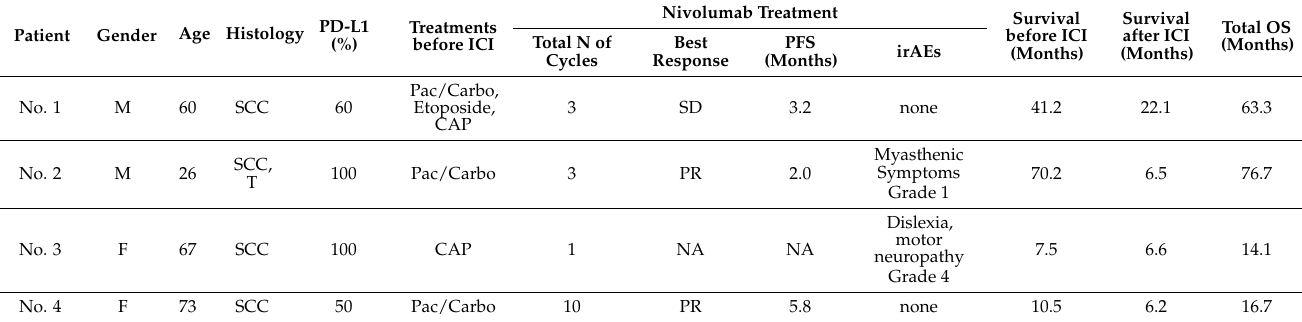
Table 2. Clinical features of four patients with thymic carcinoma (exploratory